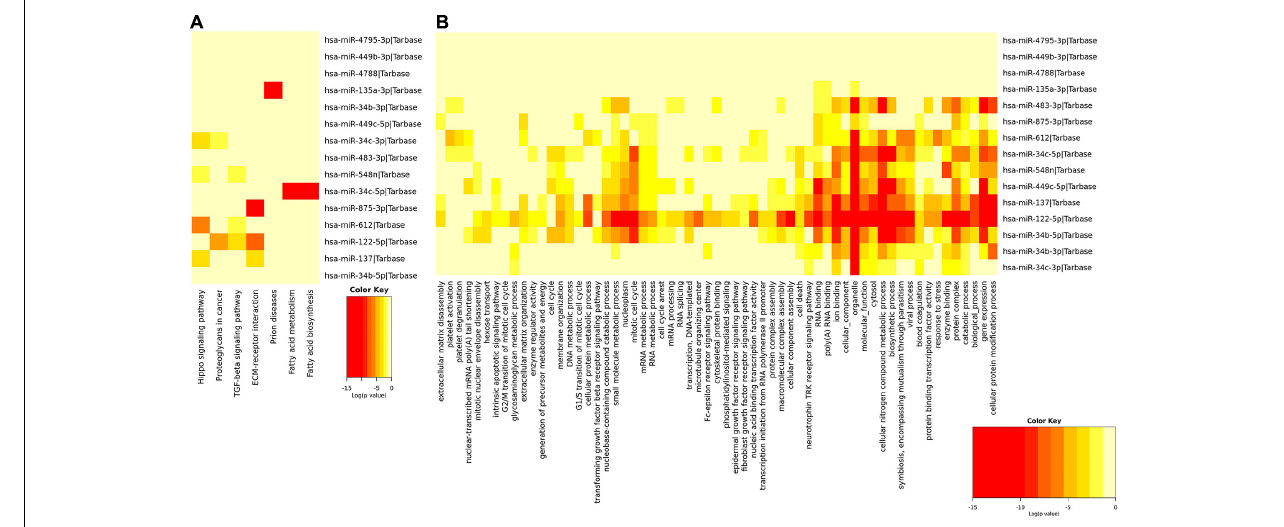
FIGURE 4 | Functional enrichment analysis of miRNAs in the signature. This figure describes the functional enrichment analysis of miRNAs in the signature. (A,B) Gene Ontology (GO) analysis and Kyoto Encyclopedia of Genes and Genomes (KEGG) biological process analysis.